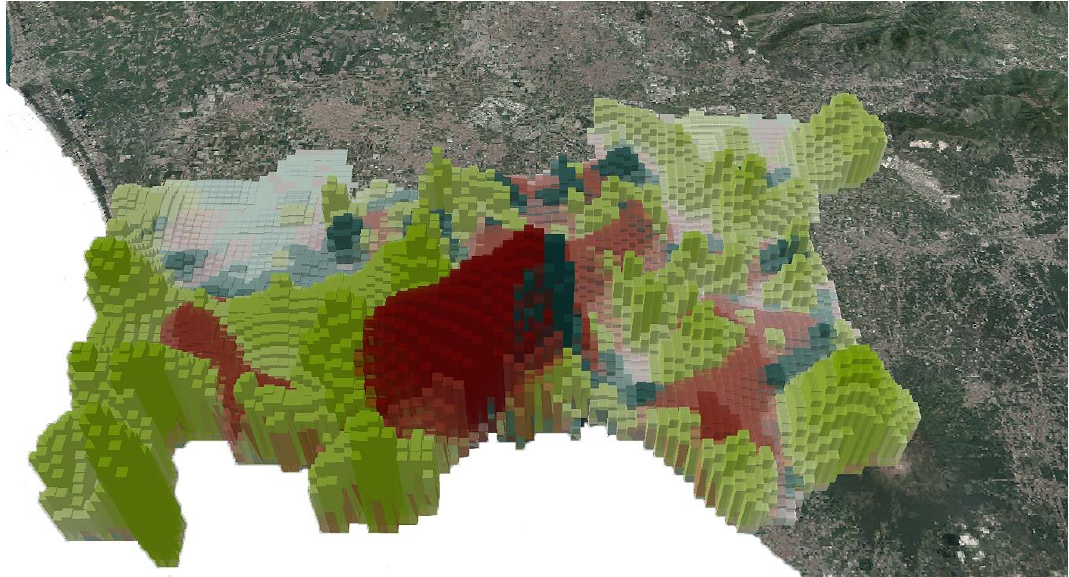
Figure 8. 3D visualisation of Regulation (green), Carrier (blue), and Information (red) service values with Jenks natural breaks categorisation. The overlay allows for visualising trade-offs among services at an overall level.